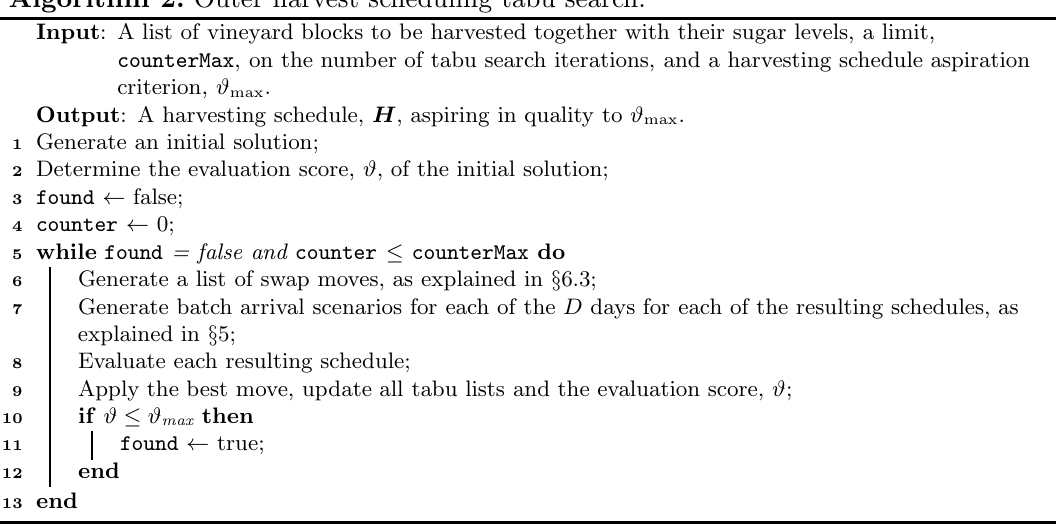
Algorithm 2: Outer harvest scheduling tabu